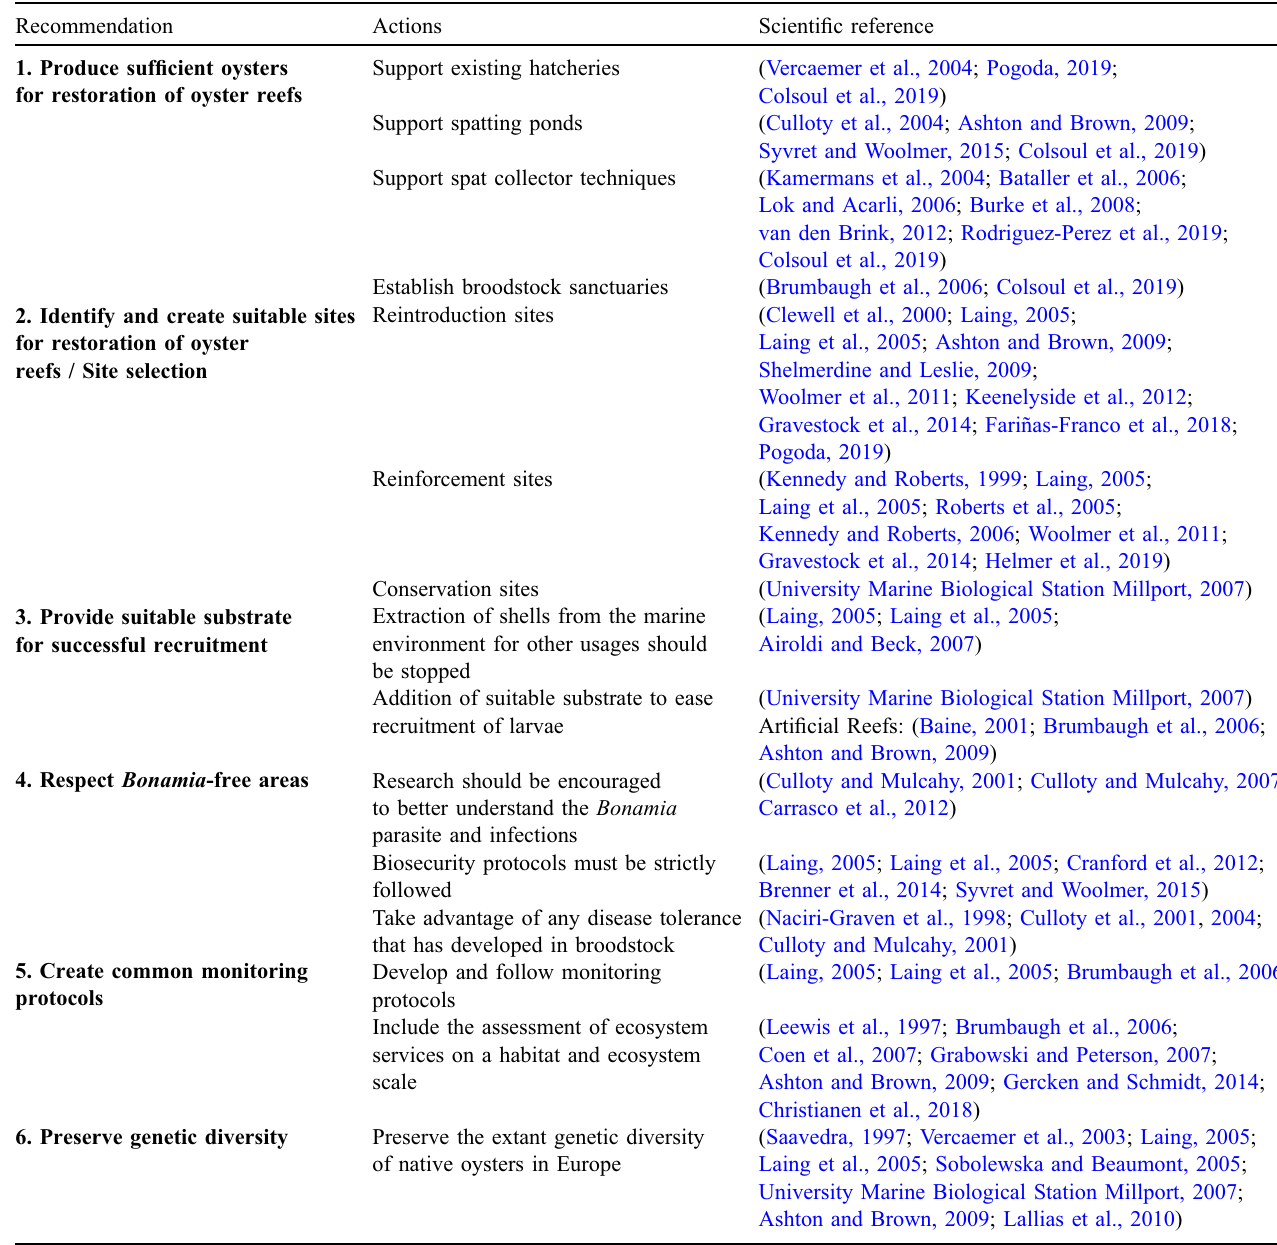
Table 1. Recommendations as listed in the Berlin Oyster Recommendation on the Future of Native Oyster Restoration in Europe. These are based on agreements of participants of the fi rst meeting of the Native Oyster Restoration Alliance (NORA) in Berlin 2017, NORA members and on a literature review focusing on restoration of Ostrea edulis